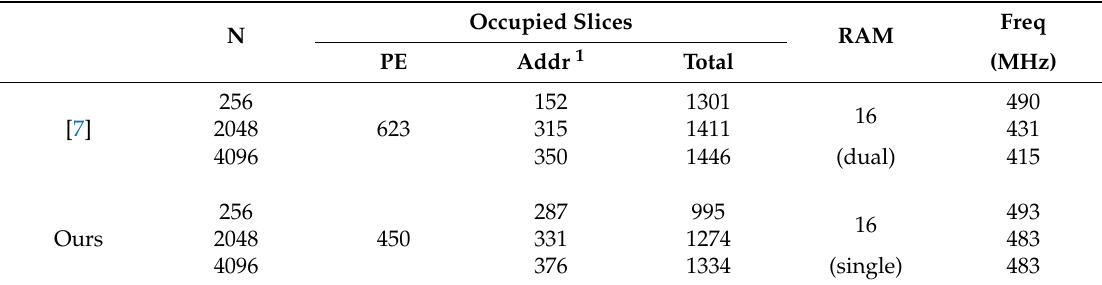
Table 3. Comparison of the experimental